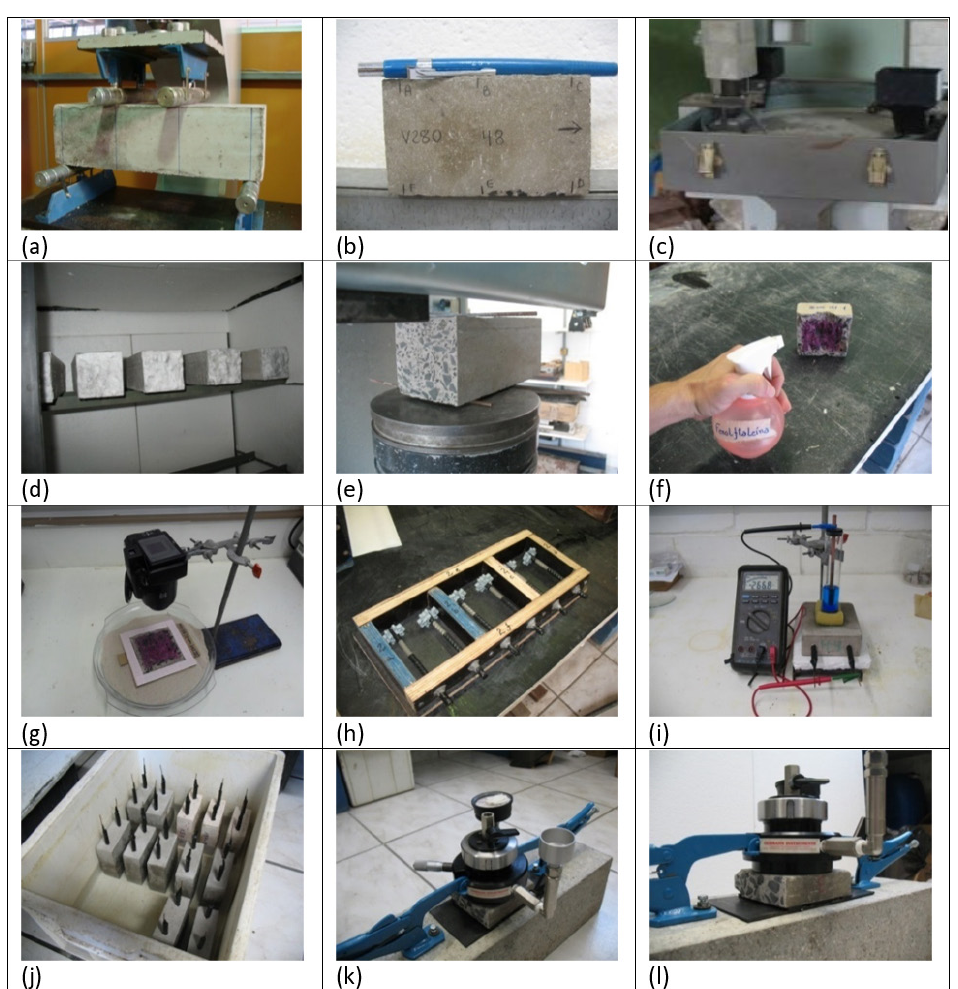
Figure 1. Illustration of details of the tests performed: (a) Four-point flexural test; (b) specimen used in the abrasion test; (c) Dorry Abrasion Machine; (d) prismatic specimens with ends sealed with wax, arranged inside the accelerated carbonation chamber; (e) slice extraction by compression (f) spraying the phenolphthalein solution on the newly fractured surface; (g) image acquisition of carbonated surface; (h) mold and reinforcement used in making specimens to test for corrosion potential; (i) assembly of the corrosion potential test, with a copper/copper sulphate electrode placed on the specimen and connected by means of a voltmeter to the working electrodes/steel bars; (j) partial immersion in sodium chloride solution to accelerate the corrosion process; (k and l) assembly of the German Water Permeability Test apparatus to assess water